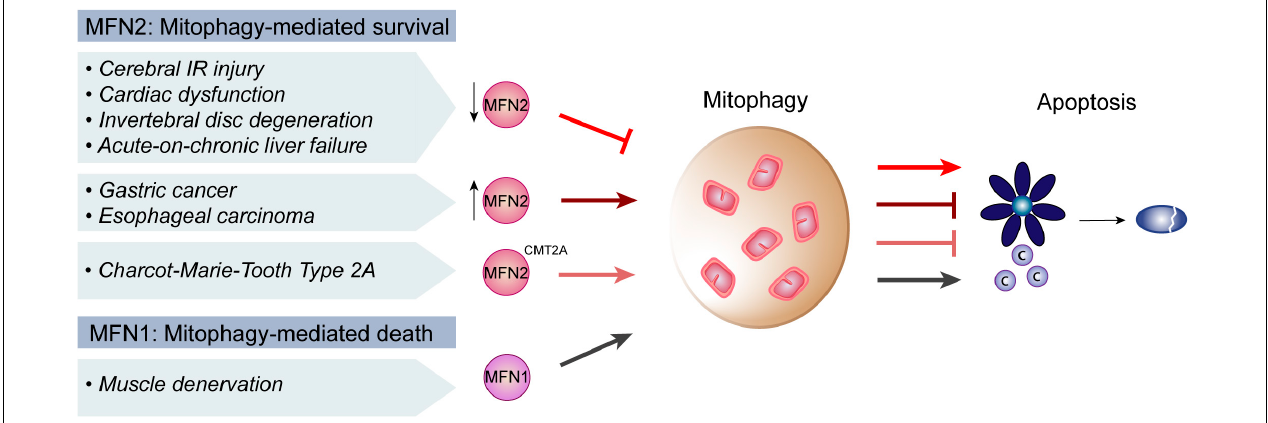
FIGURE 3 | Regulation of mitophagy and apoptosis by mitofusins in disease. In cerebral ischemia-reperfusion (IR) injury and coronary heart disease, there is a presumable decrease of Mitofusin 2 (MFN2) levels, which repressed mitophagy and induced apoptosis. Similarly, in the context of intervertebral disc degeneration, acute-on-chronic liver failure and cardiac injury, decreased MFN2 levels were concomitant with decreased mitophagy and increased apoptosis. Consistently, digestive track cancer presented increased levels of MFN2, increased mitophagy and decreased apoptosis. Moreover, MFN2 mutations causative of the neuropathy Charcot-Marie-Tooth Type 2A were also reported to induce mitophagy and block apoptosis. In contrast, upon muscle denervation, low levels of Mitofusin 1 (MFN1) lead to an induction of mitophagy which promoted apoptosis, supporting an anti-apoptotic role of mitofusins.